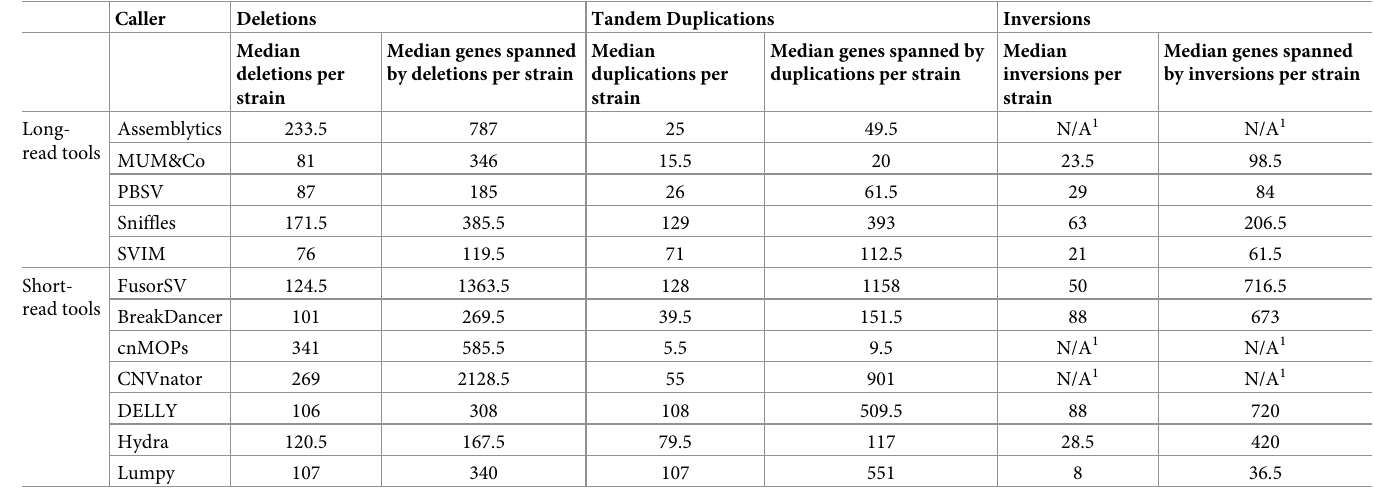
Table 4. Predicted deletions, duplications, and inversions in C . elegans